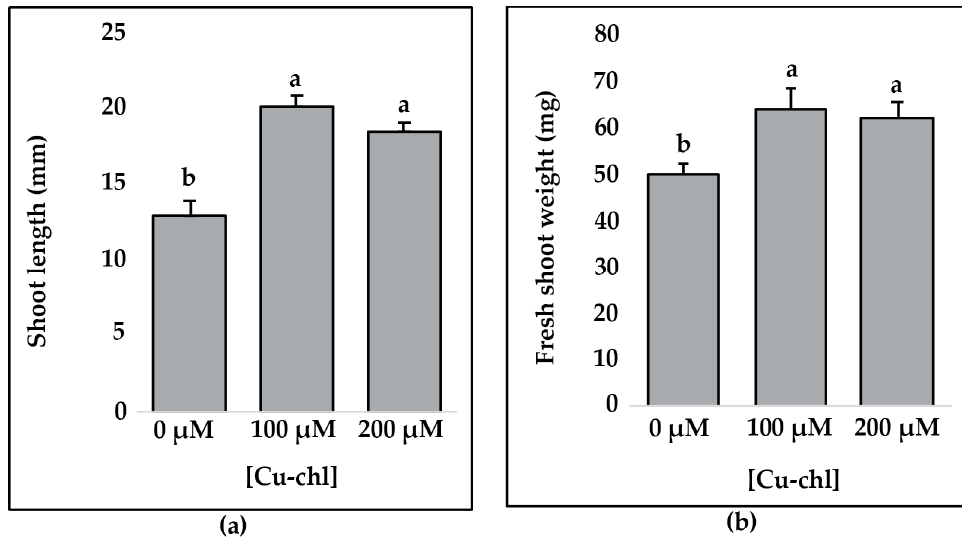
Figure 7. Effect of Cu-chl on growth and plant biomass: ( a ) shoot length of A. thaliana seedlings (n = 20, values are mean ± SE). ( b ) Fresh shoot weight (groups of four seedlings, n = 5) of the 20 seedlings measured in ( a ). Four randomly chosen seedlings were weighed together, different letters indicate significant difference between treatments according to Fisher’s least significant difference (LSD) test at p = 0.05.